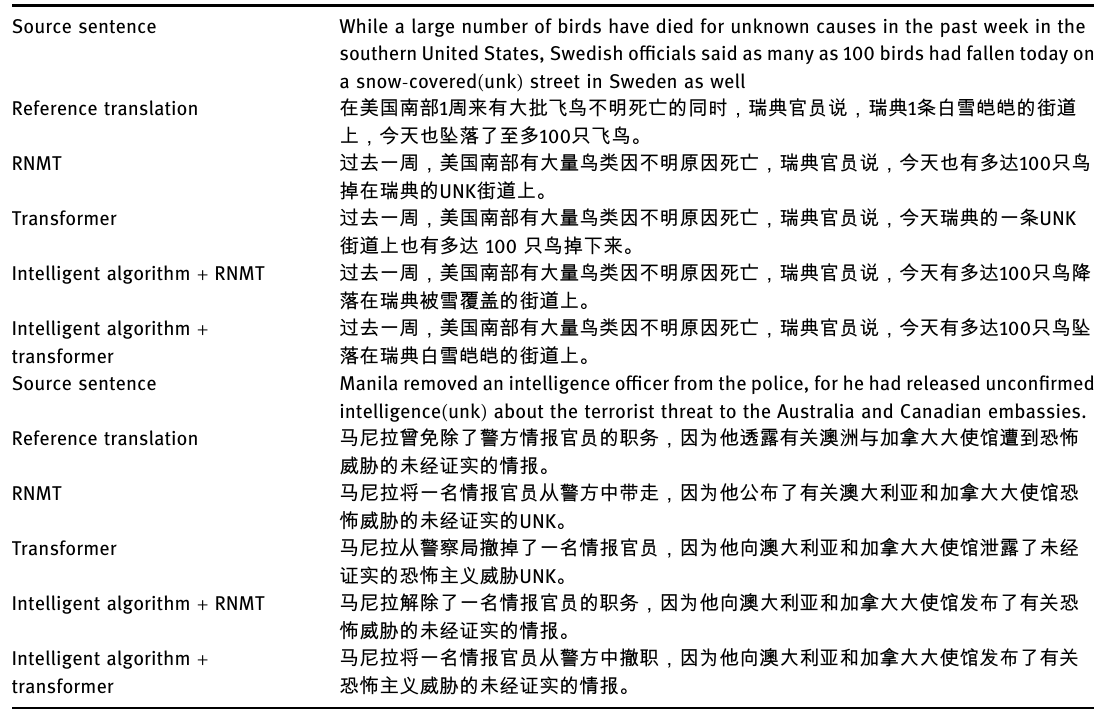
Table 3: Example sentence